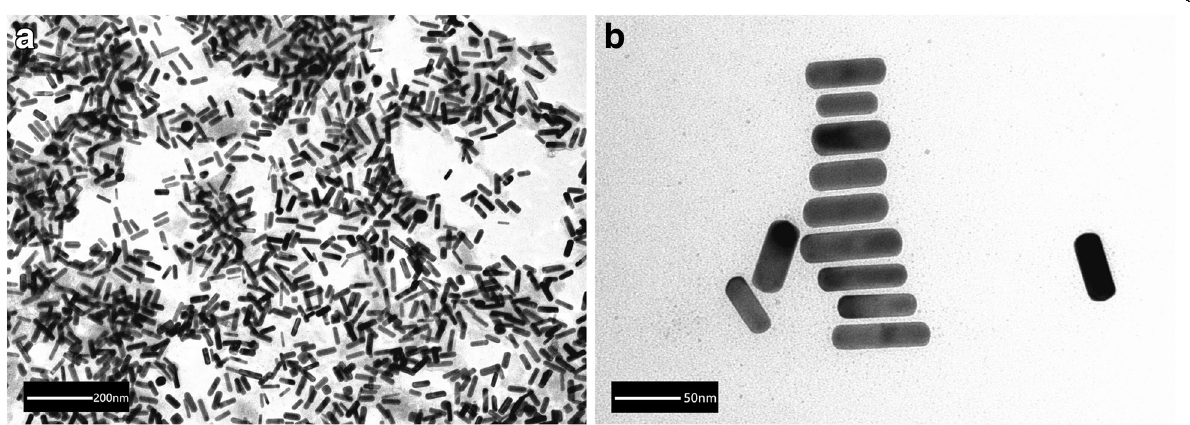
Fig. 2 a , b TEM image of GNR-SiO 2 -Ab. The nanorods presented a rod-like appearance. The shape or size of GPRs did not change when they were conjugated with anti- C.